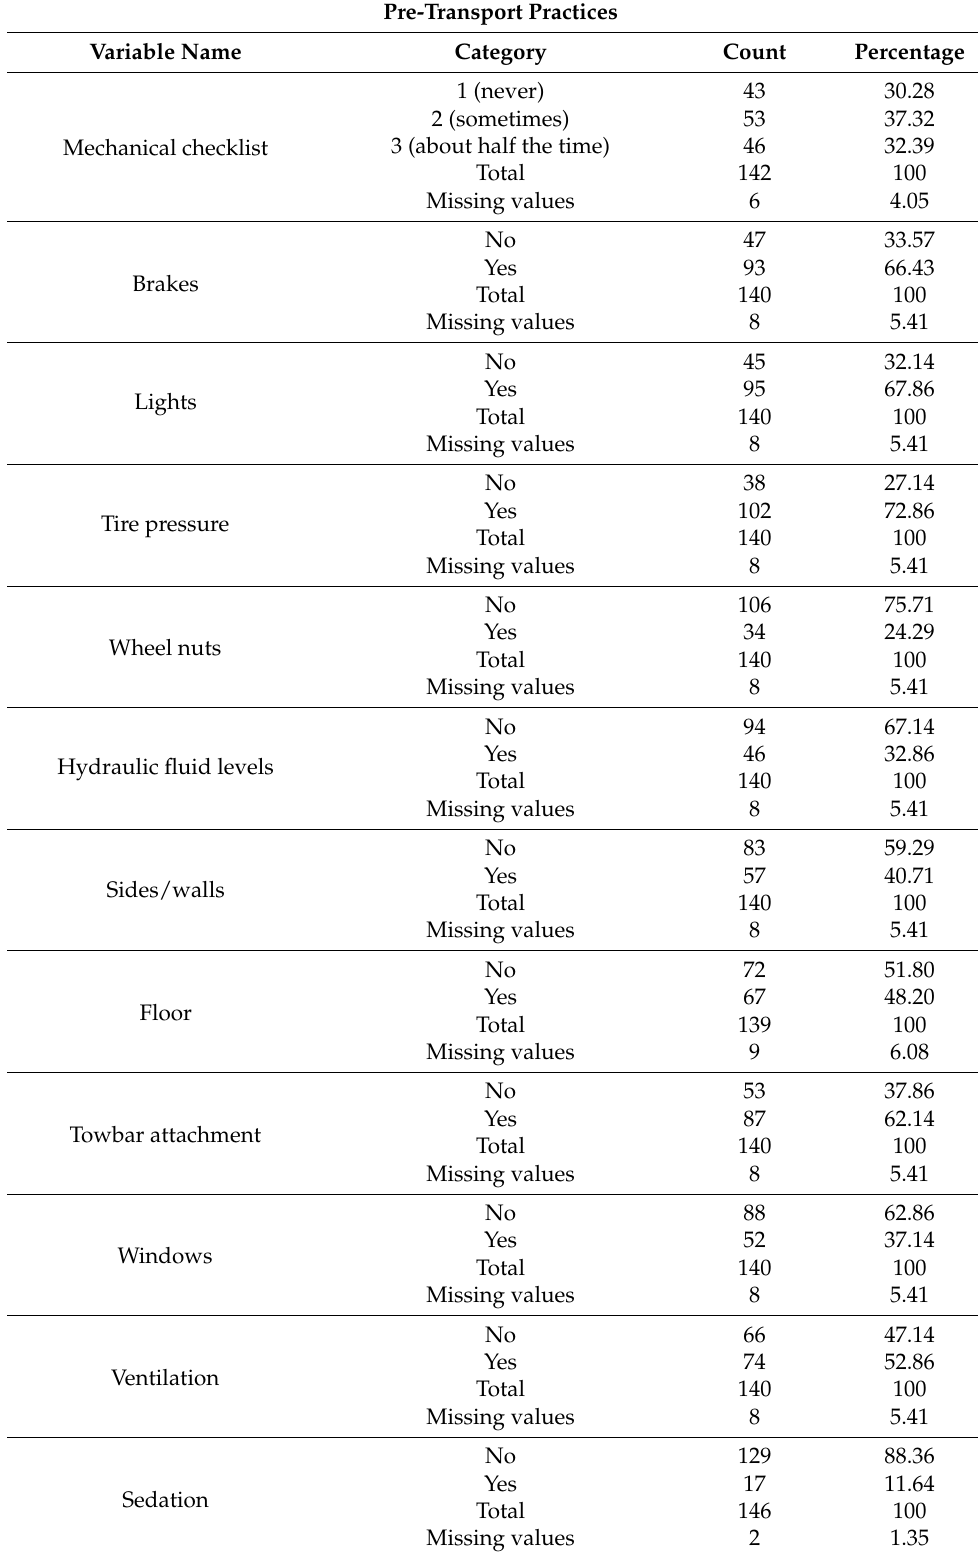
Table 5. Frequency table of the replies ( n = 148) to the pre-transport practices in a survey on horse road transport practices, transport-related problem behaviors, horse injuries, and horse handler injuries in